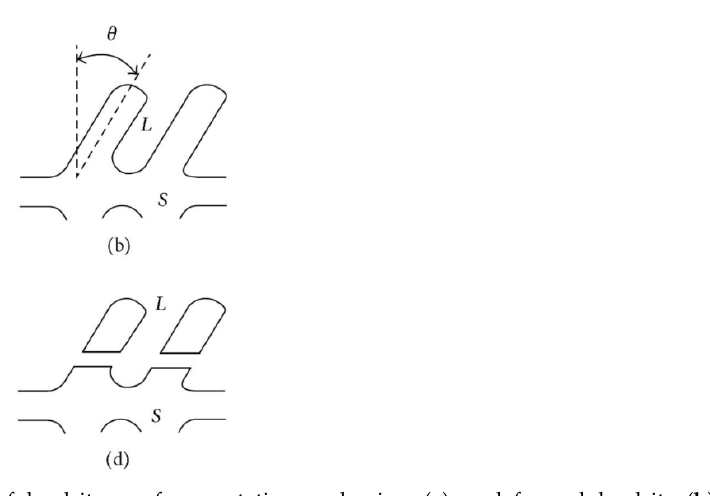
Figure 17. Schematic of dendrite arm fragmentation mechanism, ( a ) un-deformed dendrite; ( b ) after bending; ( c ) formation of high angle grain boundary by recrystallization; ( d ) fragmentation through wetting of grain boundary by liquid metal. L stands for liquid phase, and S stands for solid dendritic grain. Reprinted with permission from Ref. [173]. Copyright 1984 Elsevier.